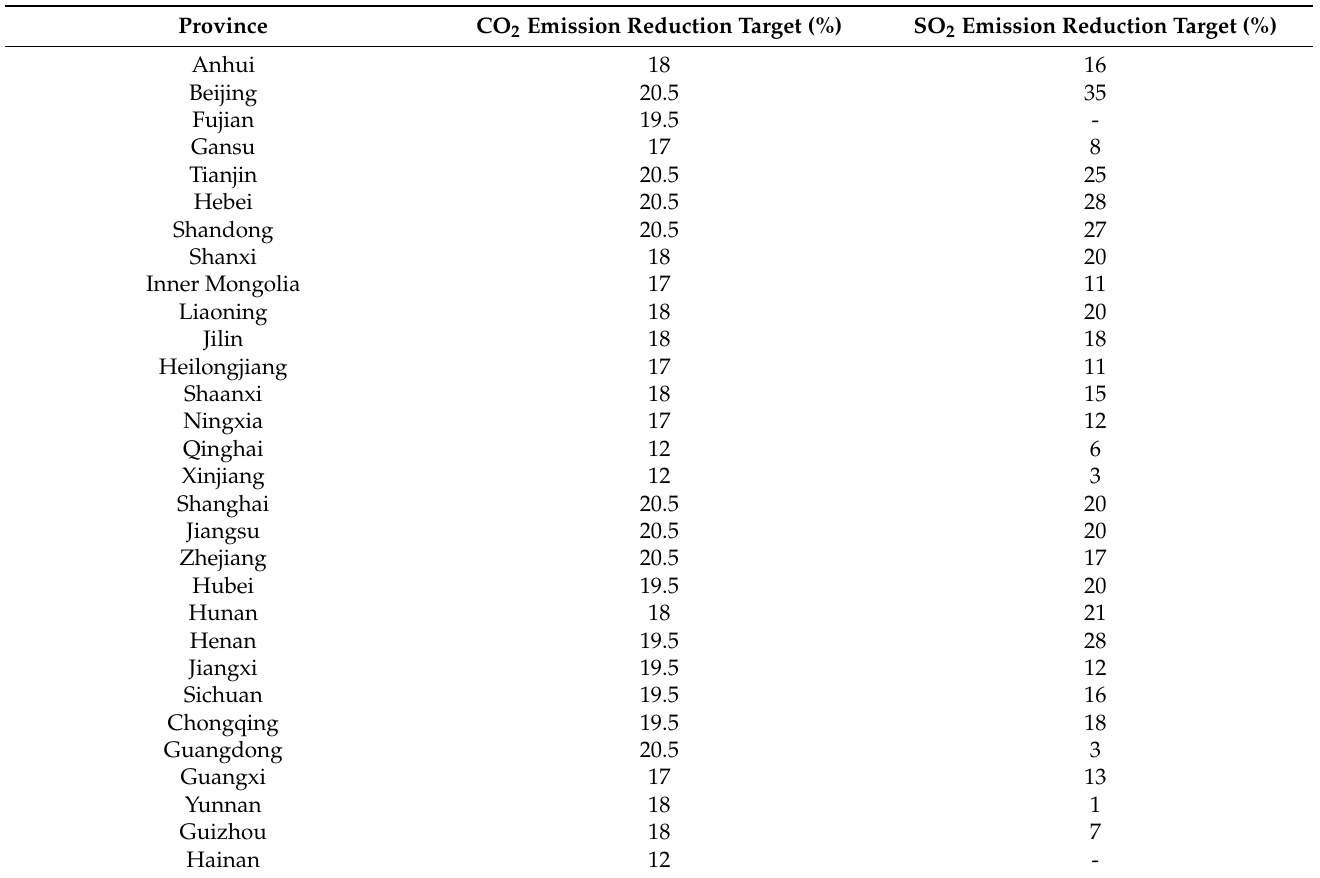
Table A4. The provincial CO 2 and SO 2 emission reduction